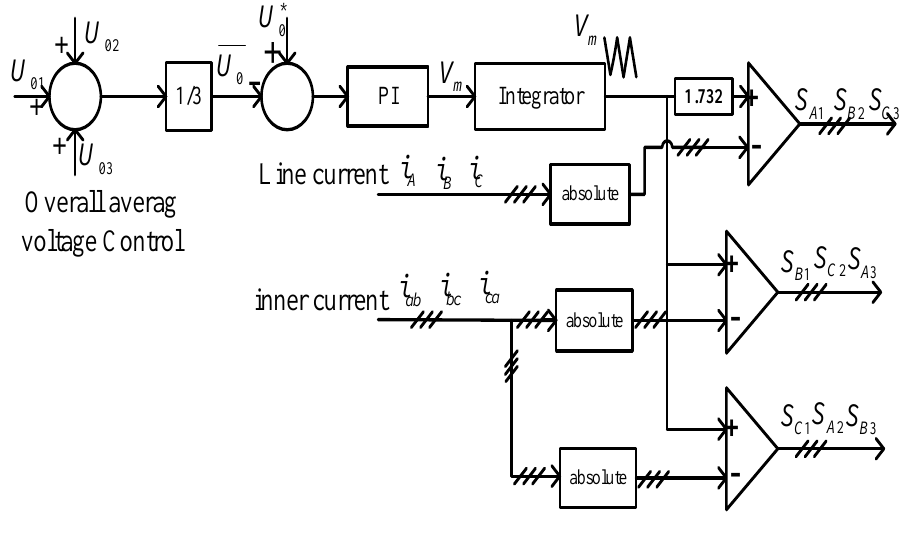
Figure 6. The one-cycle control block.